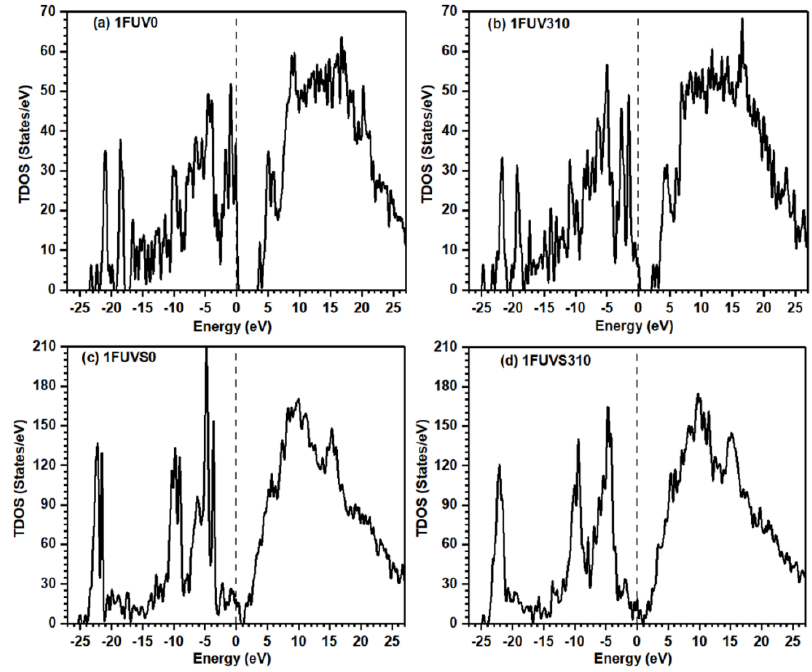
Figure 3. Calculated TDOS for dry and solvated 1FUV peptide at 0 K and 310 K.